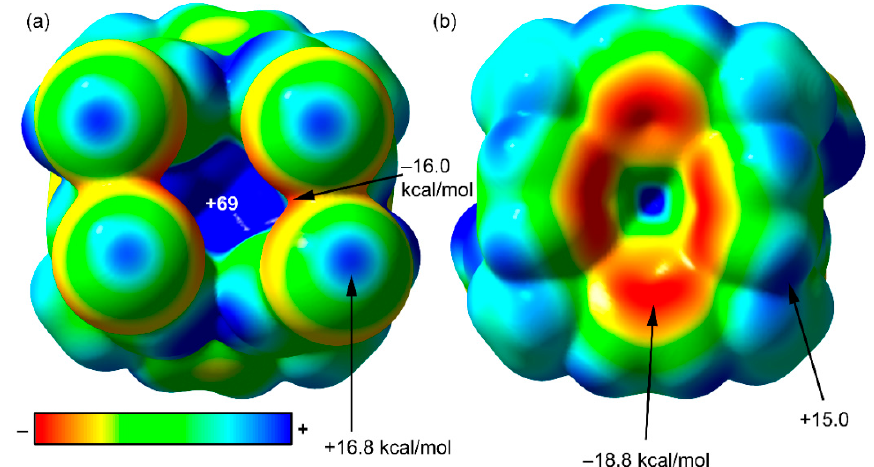
Figure 5. MEP surface of the p -iodophenyl meso-substituted calix[4]pyrrole (polymorph B ) in two zenithal orientations, C–I bonds pointing towards the viewer ( a ) and opposite to the viewer ( b ). The energies at selected points of the MEP surface are indicated in kcal/mol.